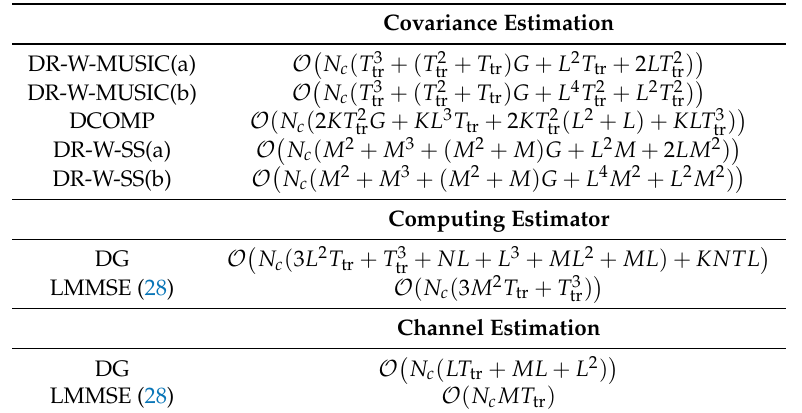
Table 1. Complexitiesof estimation